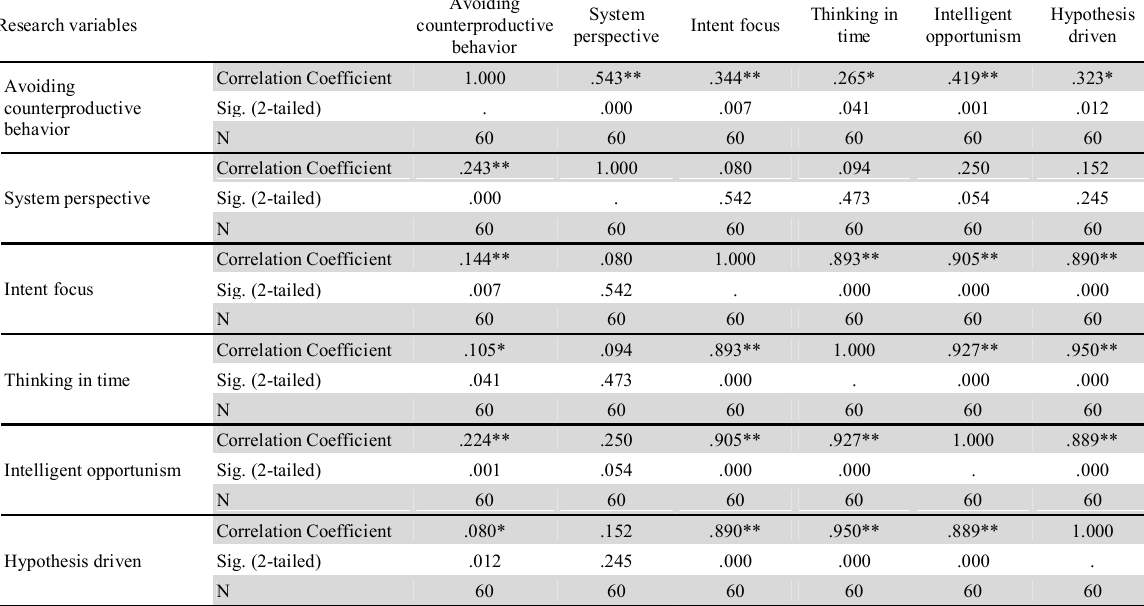
Table 2 Correlation between strategic thinking dimensions and counterproductive behavior Research variables